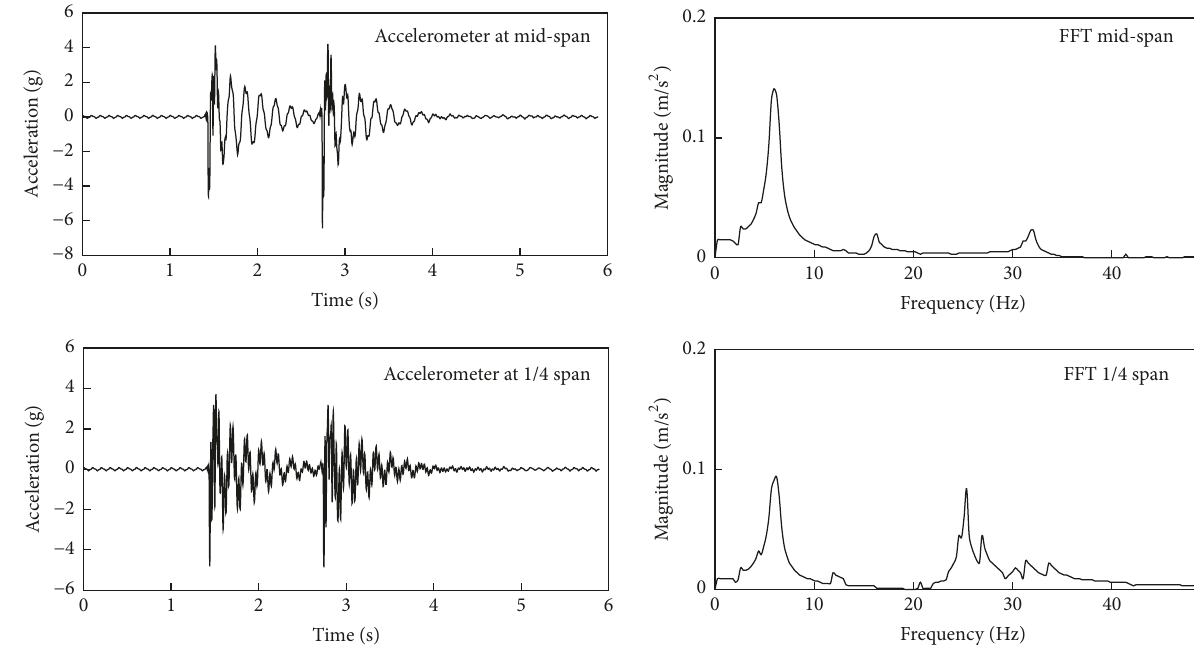
Figure 21: Time and frequency domain information from FFT accelerometers at 15:12 on 9 April 2015.